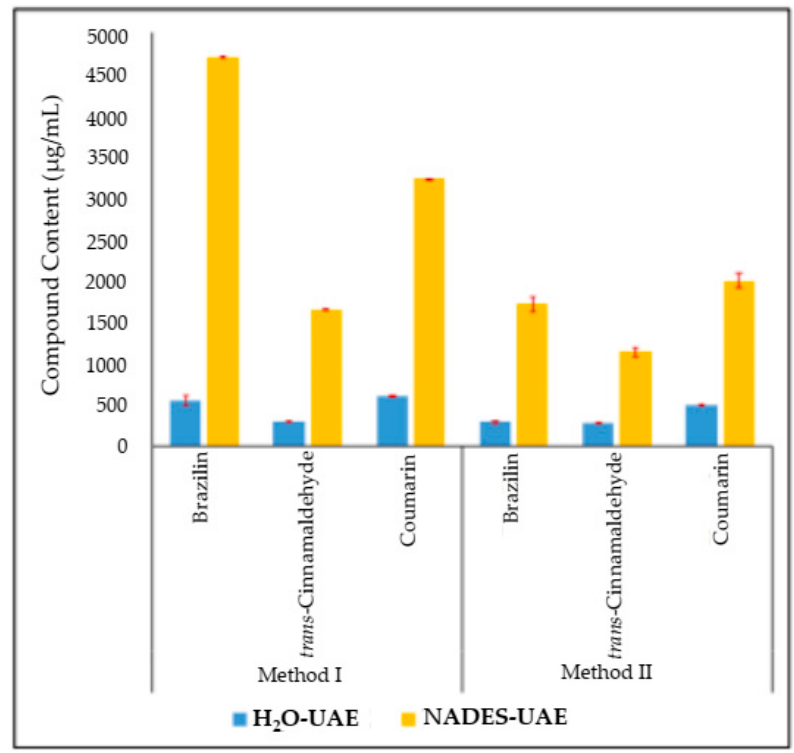
Figure 1. The ratio of compound content from extract solution using conventional solvent (H 2 O) and natural deep eutectic solvent (NADES).